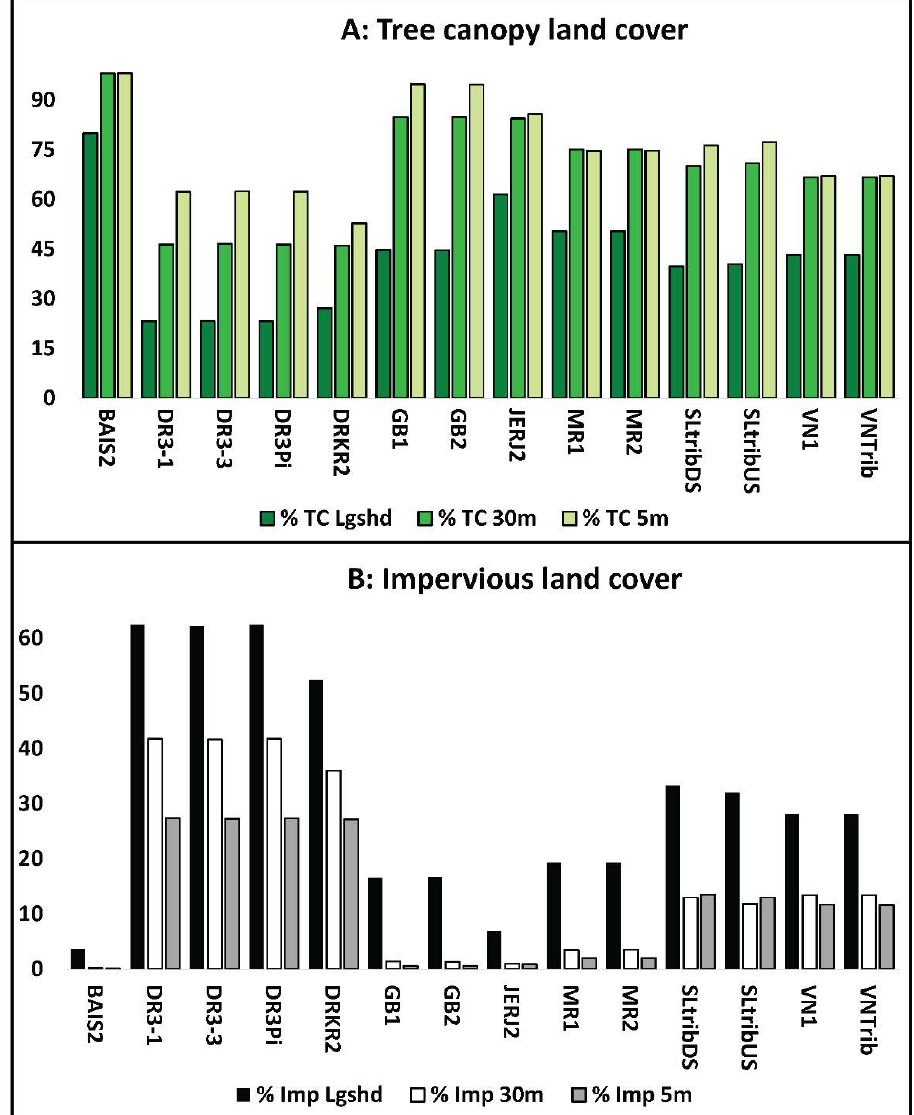
Figure 3. Tree canopy land cover percentages ( A ) and impervious land cover percentages ( B ) at study sites. ( A ) shows the percentage tree canopy within the loggershed (% TC Lgshd), within 30 m riparian areas (% TC 30m), and within 5 m riparian areas (% TC 5m). ( B ) shows the percentage impervious within the loggershed (% Imp Lgshd), within 30 m riparian areas (% Imp 30m), and within 5 m riparian areas (% Imp 5m).